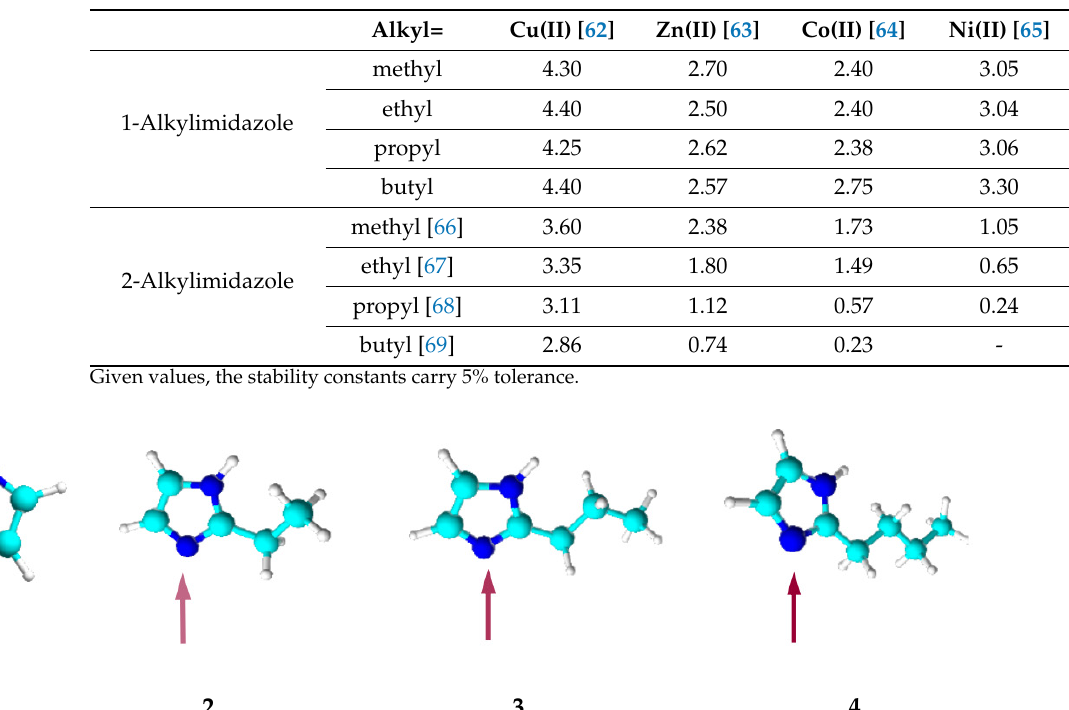
Table 4. Comparison of the stability constant values (log β ) of Cu(II), Zn(II), Co(II), and Ni(II) complexes.